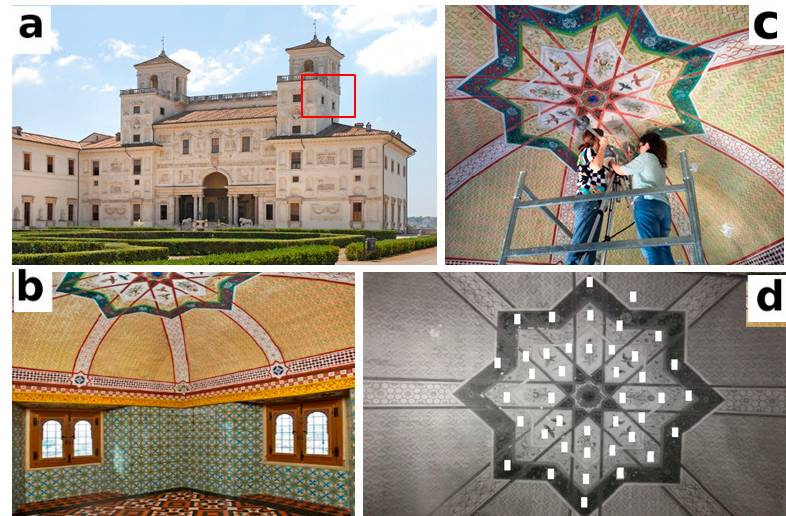
Figure 7. ( a ) Villa Medici; ( b )the Turkish room; ( c ) NMR probe mounted on its metal arm while measuring the vault surface; ( d ) Matrix of area analyzed on the vault by NMR.